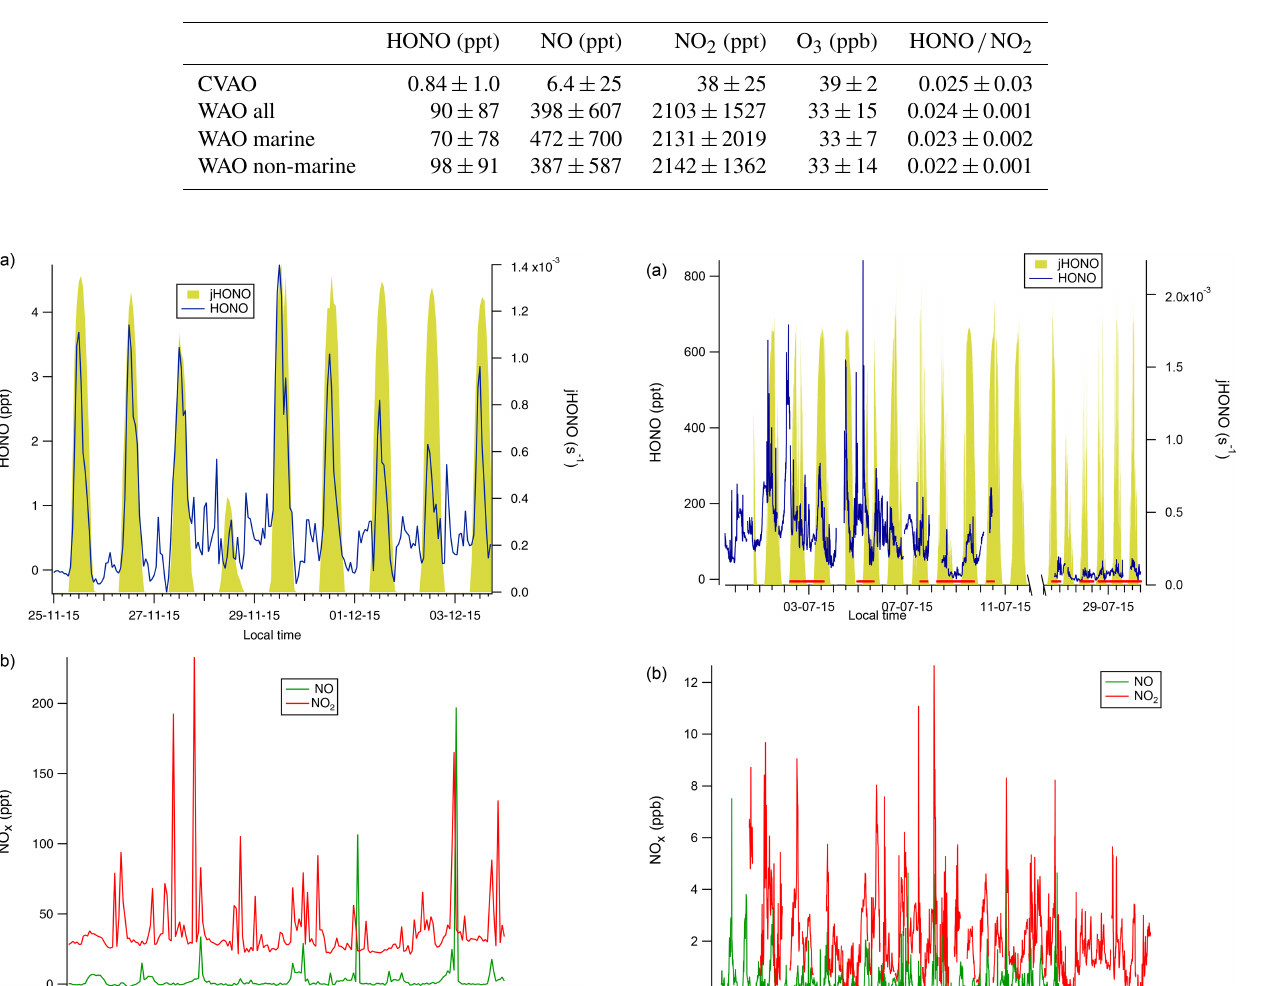
paign (namely 29 June to the 10 July), back trajectory anal- ysis indicated that air masses were mainly from the south- west (see example trajectories in Fig. S6 in the Supplement) and therefore in the pollution outflow from London (Forster et al., 2012), which likely explains the higher HONO and NO x concentrations. During periods of marine air, back